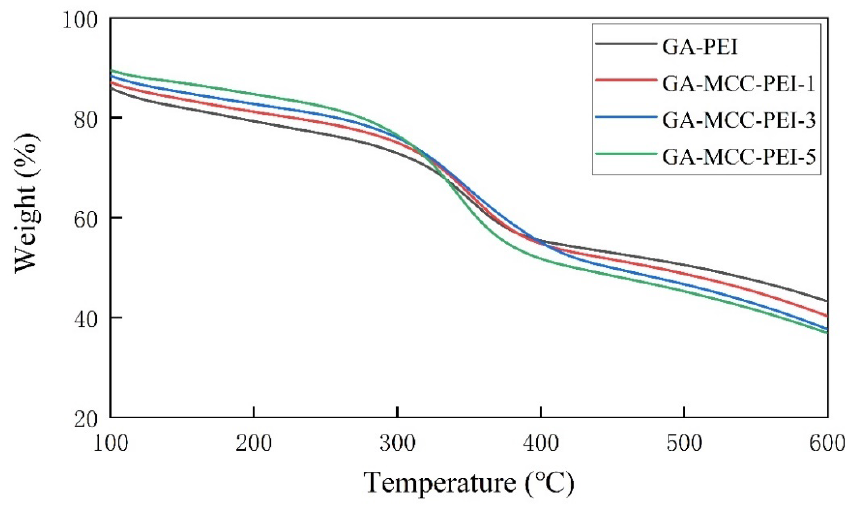
Figure 4. Thermogravimetric analysis of the GA-PEI aerogel and GA-MCC-PEI-(1, 3, 5) aerogels. From a comparison of the thermogravimetric curves of the GA-PEI and GA-MCC-PEI-(1, 3, 5) aerogels (Figure 4), as the MCC content increased, the thermal performance of the composite material increased. The stability first increased and then decreased, indicating that the hydrogen bond can enhance the thermal stability of composite aerogels. However, when the MCC content was high (GA-MCC-PEI-5), pyrolysis of a large amount of MCC reduced the thermal stability of the sample. The thermogravimetric loss of 30 wt.% occurred at 322.2 ◦ C for the GA-PEI aerogel, 330.4 ◦ C for GA-MCC-PEI-1, 332.4 ◦ C for GA-MCC-PEI-